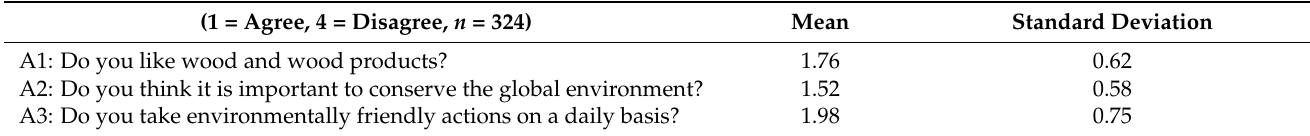
Table 3. Results of the Attitude Questionnaire: A1–A3.